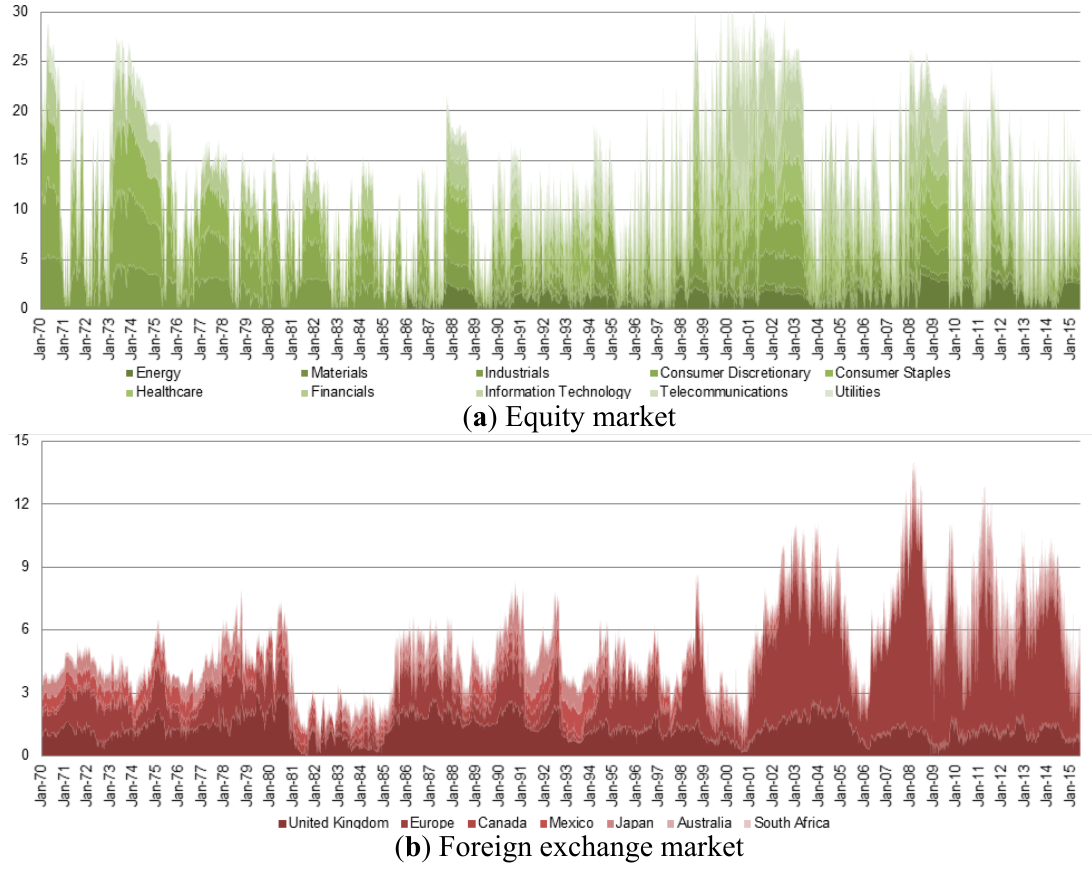
Figure 6. Financial stress in the equity ( a ) and foreign exchange ( b ) markets in terms of their constituent